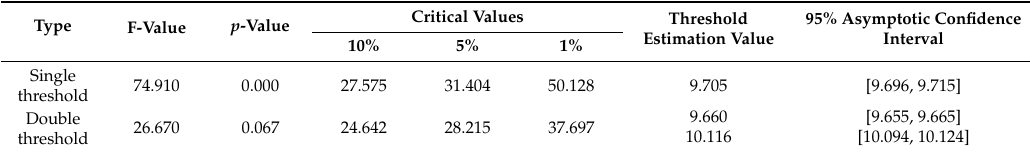
Table A5. The significance test results for financial development (FD) threshold e ff ects.